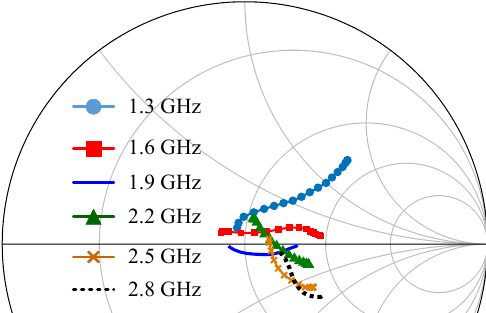
Figure 7. Simulated load modulation trajectories of the carrier transistor at the internal